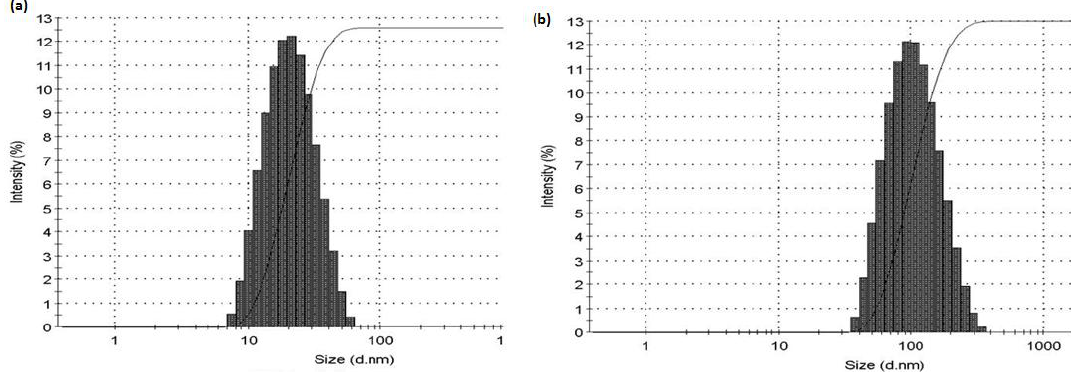
Figure 5. Average hydrodynamic radius of ( a ) GNP ( b ) GNP conjugated wsMWCNTs.